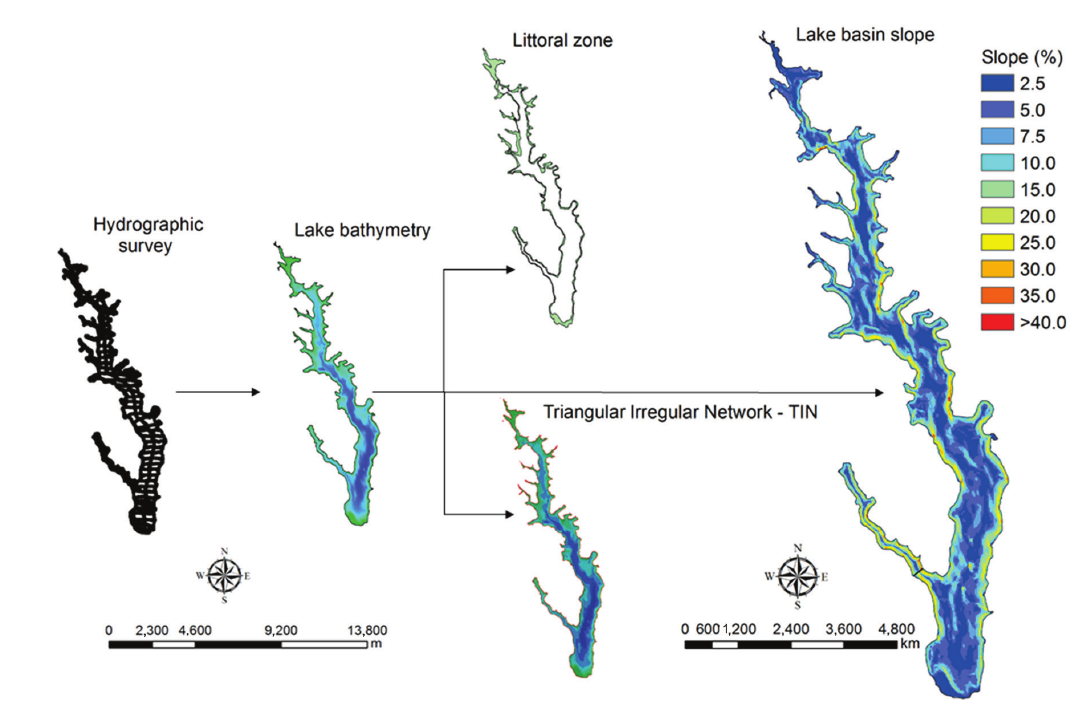
Figure 2 - GIS rasters created from interpolation of depth point data: lake bathymetry, triangular irregular network – TiN and basin